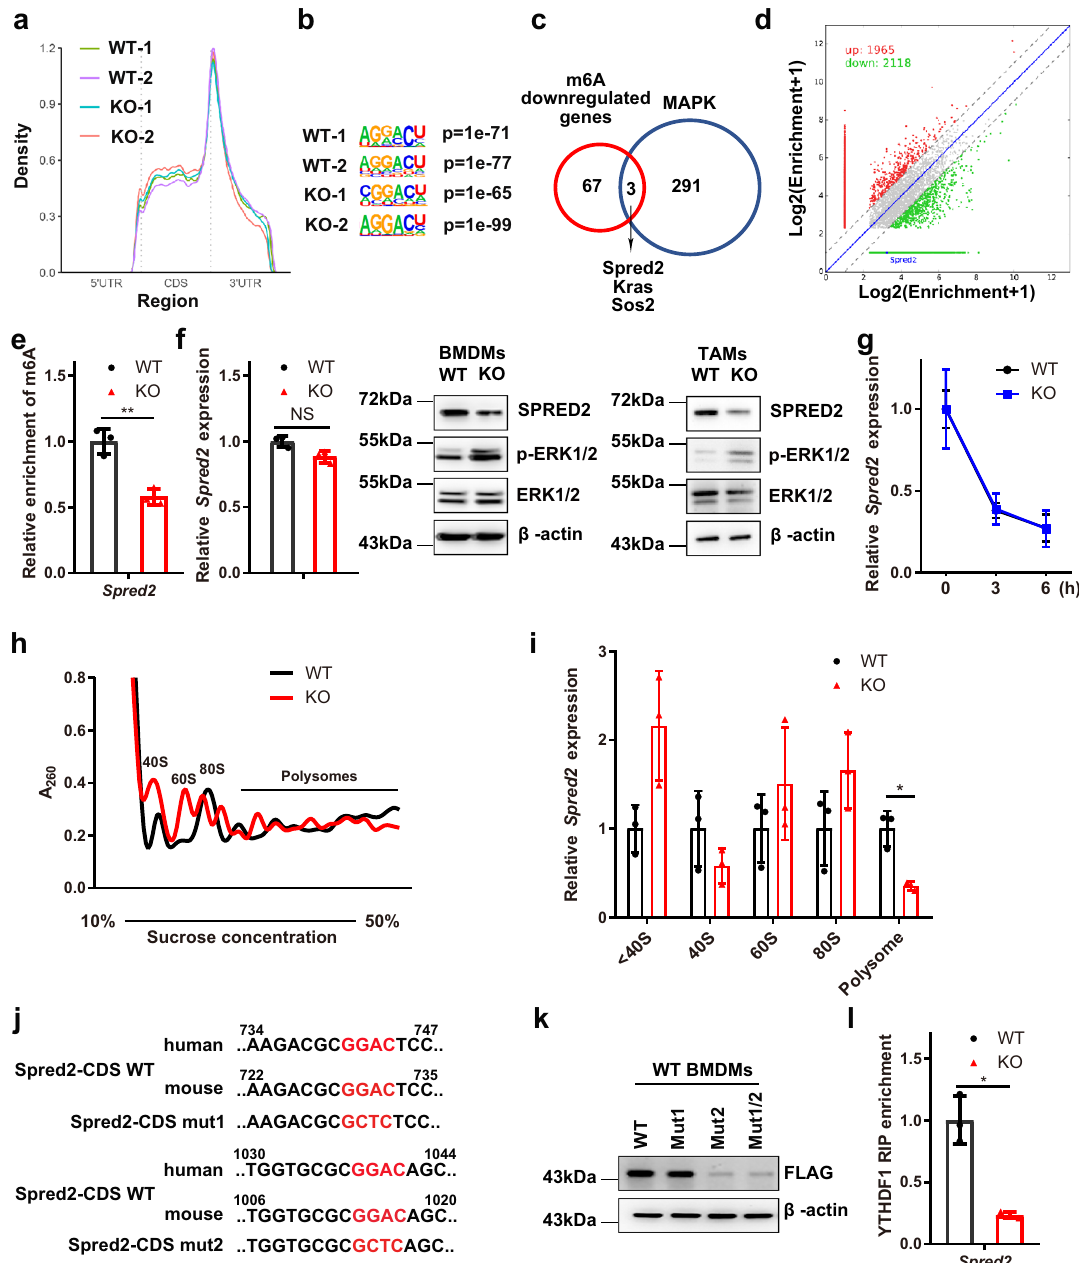
Fig. 6 Loss of METTL3 impairs the YTHDF1-mediated translation of SPRED2. a Metagene pro fi les of the m6A distribution across the transcriptome in WT and KO BMDMs. b Consensus sequence motif for m6A methylation identi fi ed in WT and KO BMDMs. c Overlap between m6A-downregulated genes (fold-change >4 and P value < 0.00001) in BMDMs and MAPK pathway-related functional genes. d Scatter plots showing m6A-related changes in cellular transcript levels in KO BMDMs versus WT BMDMs. e m6A enrichment in Spred2 mRNA in WT and KO BMDMs, as determined by m6A-RIP-qPCR. n = 3 independent experiments. f qRT-PCR (left panel) of SPRED2 expression in WT and KO BMDMs ( n = 3 mice per group). The expression of SPRED2 in BMDMs (middle panel) and TAMs (right panel) was determined by immunoblotting. The blots are representative of n = 3 independent experiments. g Spred2 mRNA stability in WT and KO BMDMs treated with actinomycin D at the indicated times determined by qRT-PCR ( n = 3 mice per group). h A representative polysome gradient pro fi le for WT and KO BMDMs. i Analysis of Spred2 mRNA in the non-ribosomal fraction (<40S), 40S, 60S, 80S and polysomes of KO BMDMs compared to those of control cells. n = 3 independent experiments. j Schematic representation of mutations in the conserved coding sequence (CDS) for the investigation of the roles of m6A in SPRED2 expression. k FLAG-SPRED2-CDS WT, FLAG-SPRED2-CDS mut1, FLAG- SPRED2-CDS mut2 or FLAG-SPRED2-CDS mut1/2 was transfected into BMDMs for 24 h. Protein expression was measured by western blotting. The blots are representative of n = 3 independent experiments. l RNA immunoprecipitation (RIP) analysis of the interaction of Spred2 mRNA transcripts with YTHDF1 in WT and KO BMDMs. Enrichment of Spred2 was measured by qRT-PCR. n = 3 independent experiments. Data are means ± SD. P values were determined by hypergeometric test ( b ) and two-tailed t -test ( c , e – g , i and l ). * P ≤ 0.05 and ** P < 0.01. NS (non-signi fi cant) means P > 0.05. The source data are provided as a Source data fi